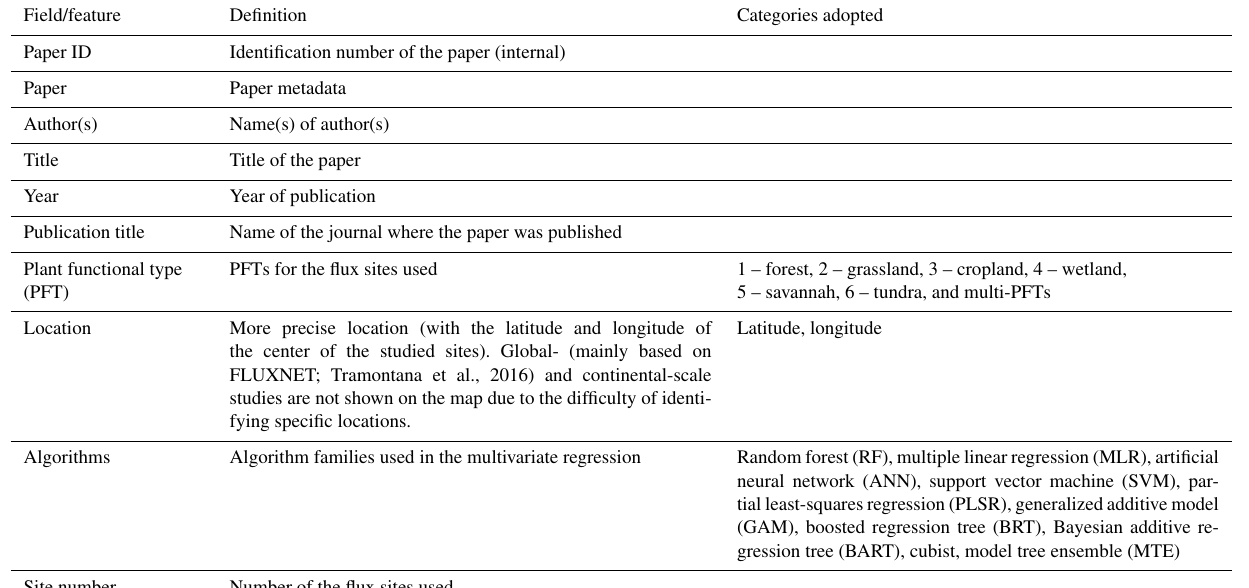
Algorithm families used in the multivariate